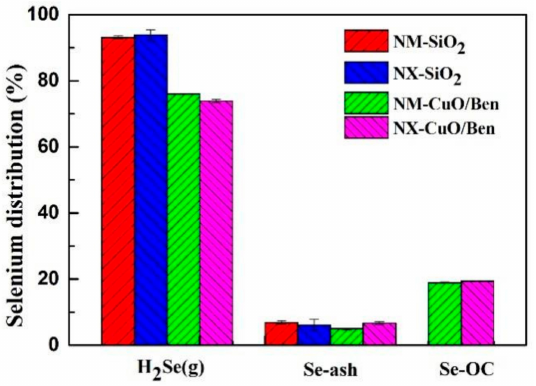
Figure 7. Selenium distribution of NM and MX coal during